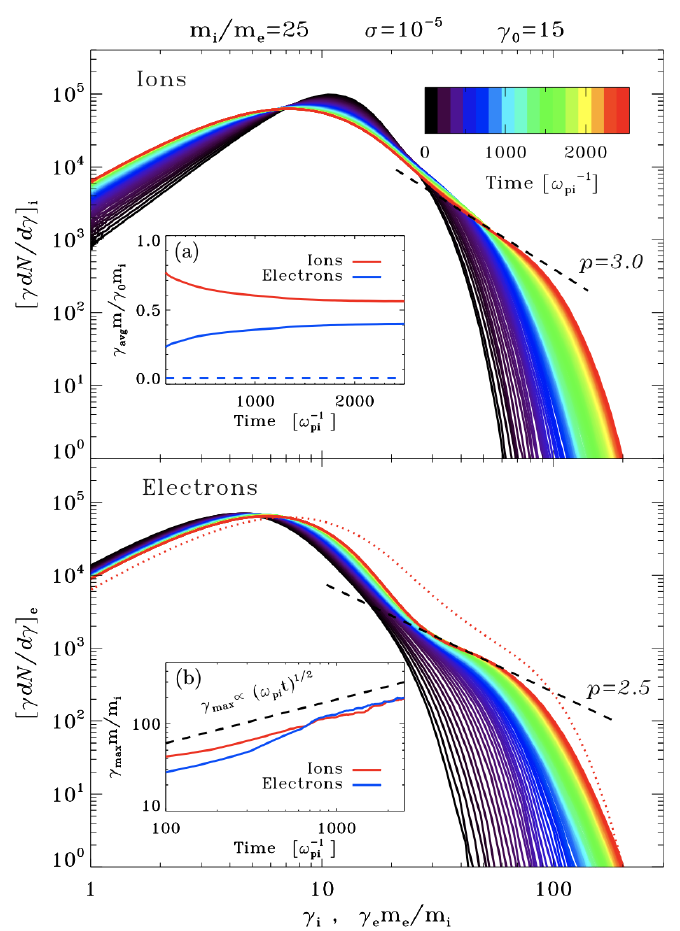
Figure 2. PIC simulations: temporal evolution of the downstream spectrum of ions ( upper panel) and electrons ( bottom ) for mass ratio m i / m e = 25, shock Lorentz factor Γ = 15 and magnetization σ = 10 − 5 . The evolution is followed until t = 2500 ω − 1 . Inset (a): mean post-shock ion (red) and pi electron (blue) energy (in units of the bulk energy of the upstream flow). The dashed blue line shows the electron energy at injection. Inset (b): temporal evolution of the maximum Lorentz factor of ions (red) and electrons (blue). For comparison, the black dashed line shows the scaling γ max ∝ ( ω pi t ) 1/2 . From [42]. ©AAS. Reproduced with